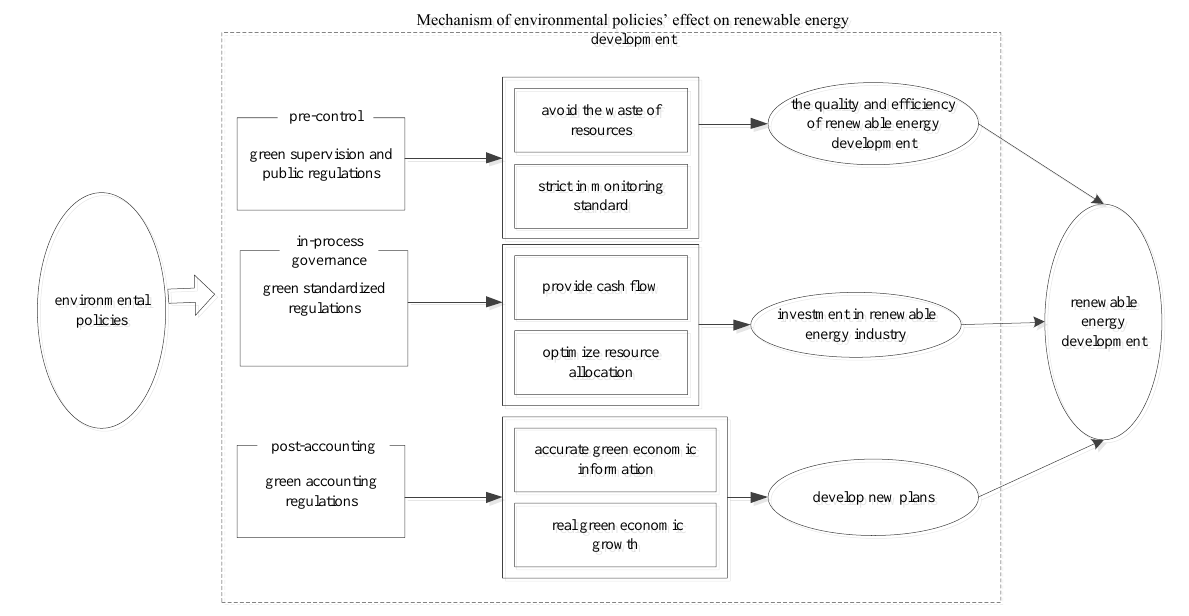
Figure 1. Mechanisms of environmental policies’ effects on renewable energy development.